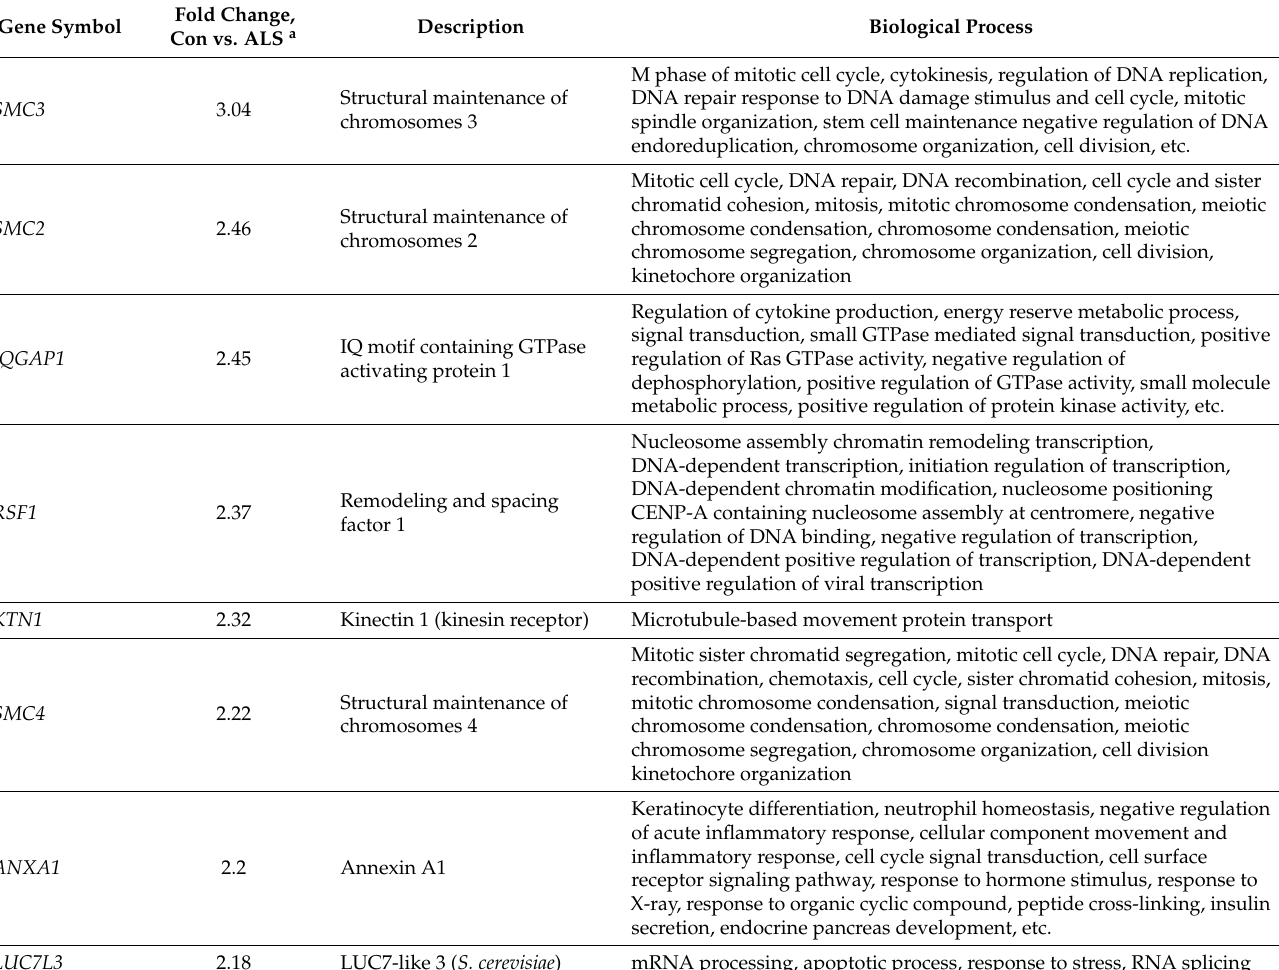
Table 1. List of differentially regulated genes in human epidermal melanocytes in response to 5 µ g/mL saponins-rich argan leaves (ALS) treatment ( ≤ 2 or ≥ 2 fold change) as determined by Affymetrix Transcriptome Analysis Console